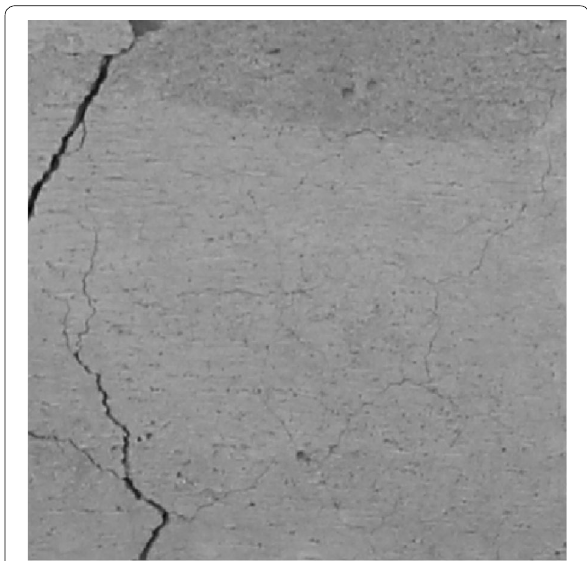
Fig. 9 Surface cracks of specimens from optical observation.